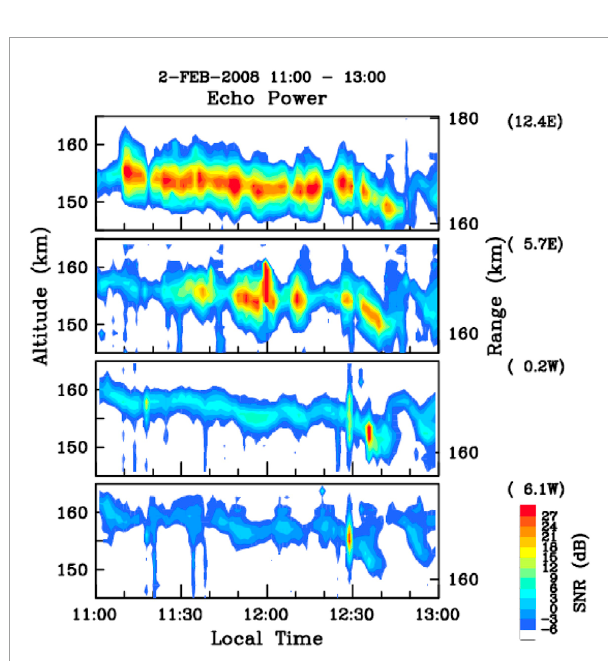
day-to-day variability. More details on these observations and the systems used can be found in Patra (2011) and Rodrigues et al. (2011),